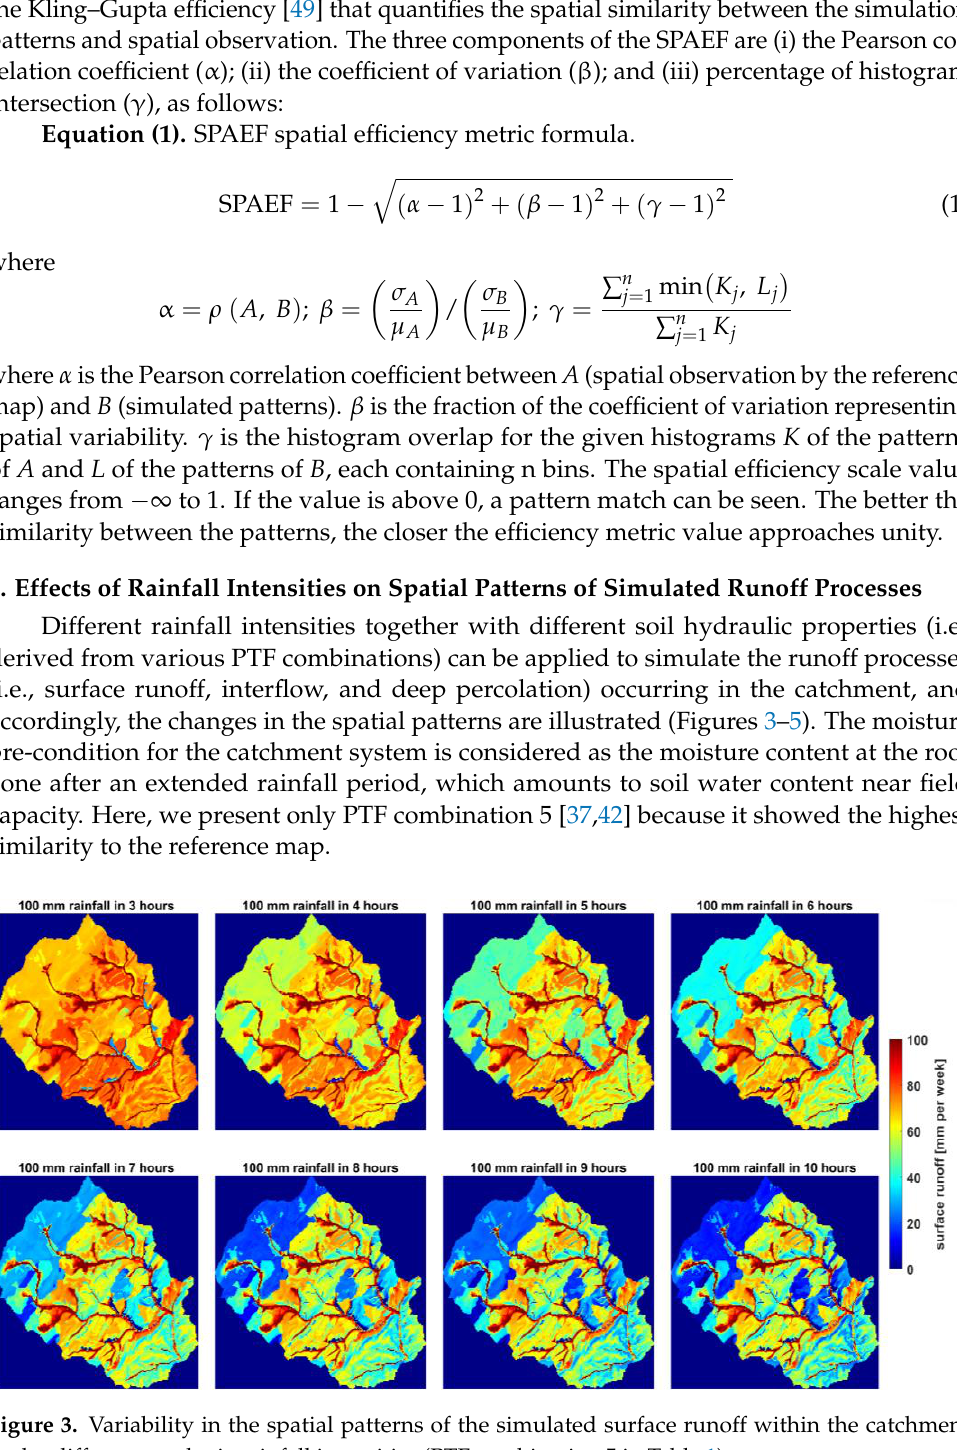
Figure 3. Variability in the spatial patterns of the simulated surface runoff within the catchment under different synthetic rainfall intensities (PTF combination 5 in Table 1). under different synthetic rainfall intensities (PTF combination 5 in Table